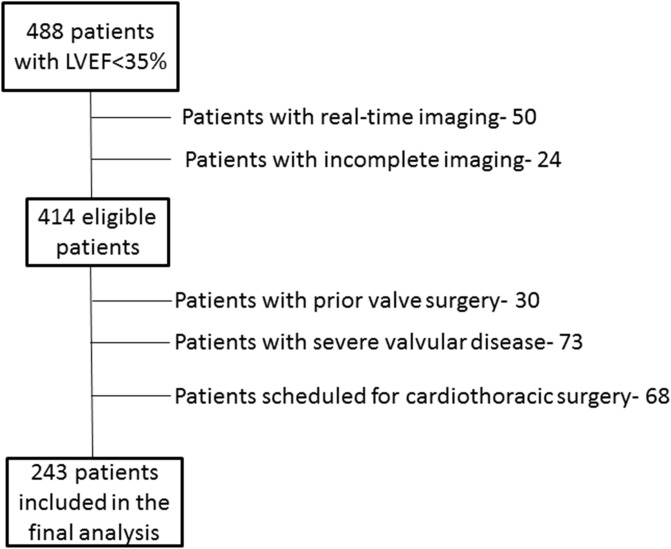
Patient flow chart.